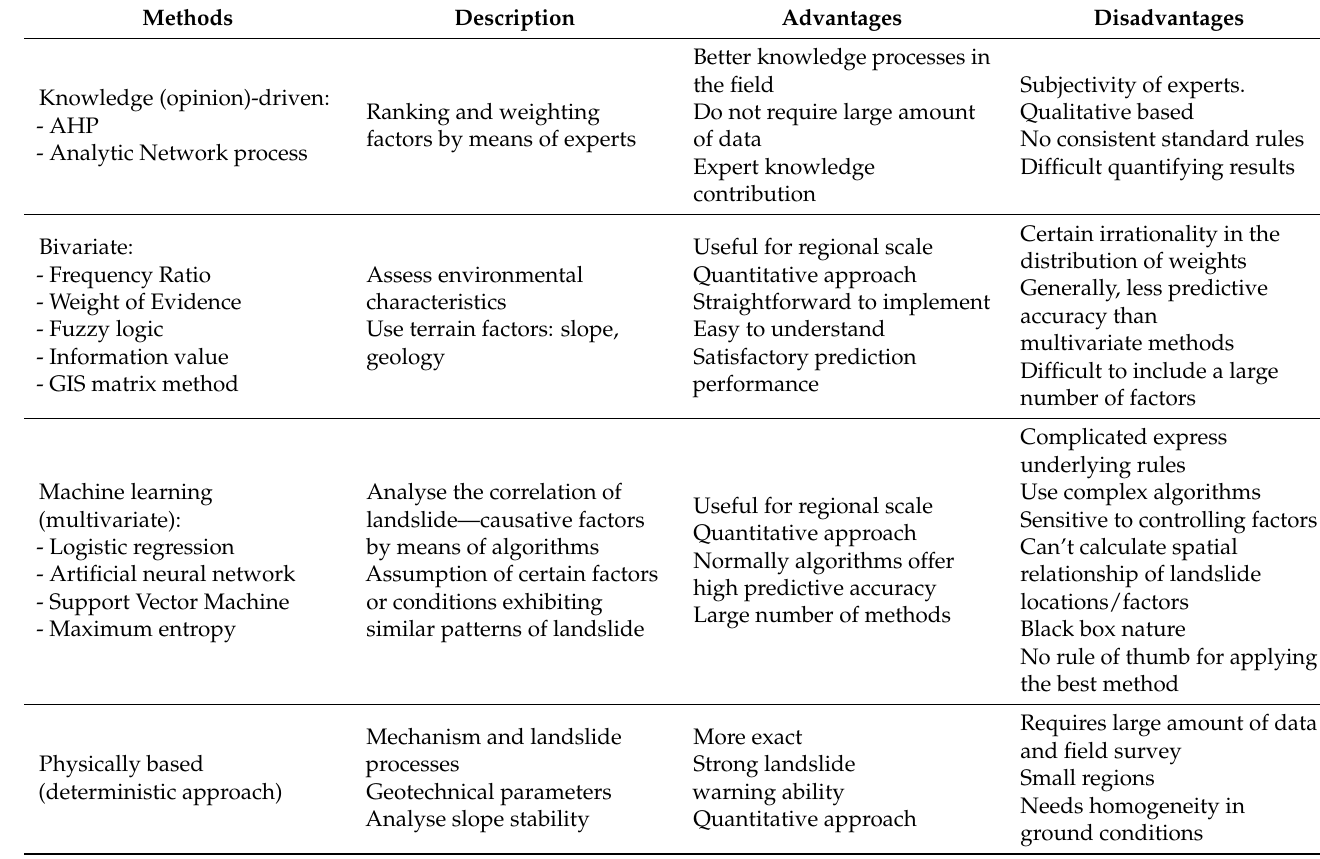
Table 1. Methods for Landslide Susceptibility Assessment